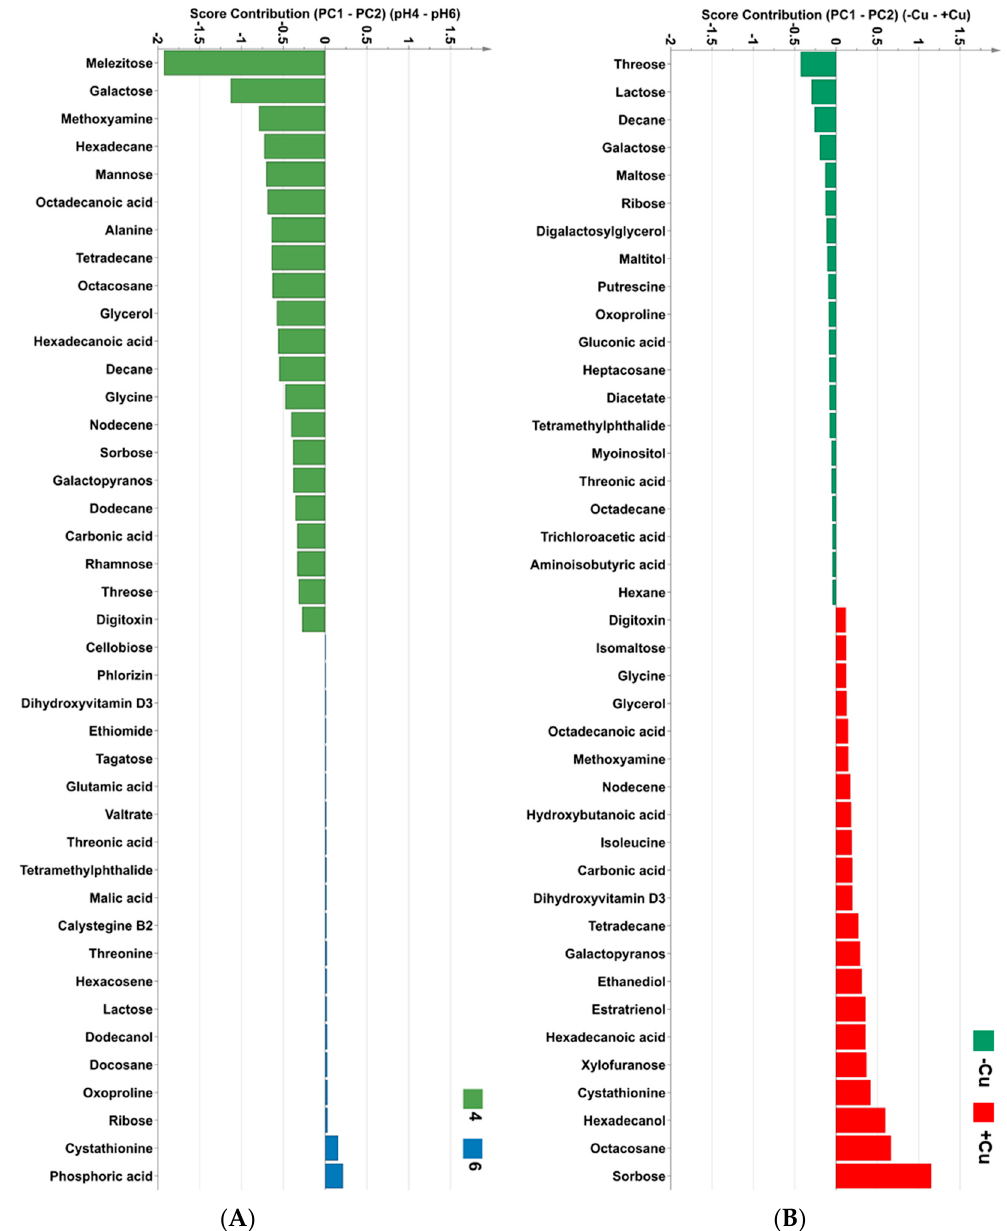
Figure 7. The score contribution plot values (top 40) that contribute towards GC-MS PCA loading plots of Desmodesmus sp. AARLG074 under different treatments ( A ) pH and ( B ) copper. The score contribution plot values (top 40) were ranked in order of importance and are negative if they contribute towards PCA loading plot for the pH 4 (green) and positive if they contribute towards the pH 6 (blue) and positive for copper stress (red) and negative if they contribute towards control (without copper) (green). The full list of the metabolites is presented in supplementary (Figures S1 and S2).